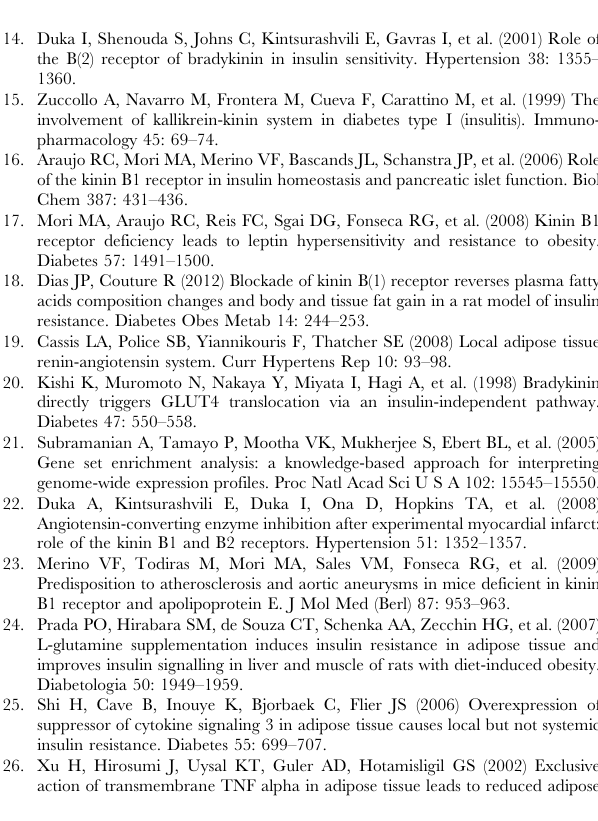
Figure S4 Lipid and glucose metabolism genes are not rescued by expression of kinin B 1 receptor in fat. Expression of GLUT1, fatty acid synthase (FAS), acetyl-CoA carboxylase (ACC) and glycerol-3-phosphate acyltransferase-like (GPAT) mRNA in epididymal fat of random fed mice measured by realtime PCR. Data represent mean 6 SEM of six animals per group. *, P , 0.05; **, P , 0.001. (TIF) Figure S5 aP2-B1/B1 2 / 2 mice have smaller adipo- cytes. Animals were submitted to HFD and adipocyte size was estimated in histological sections of the epididymal fat pad. Values are means 6 SEM of six animals. Table S1 Gene Set Enrichment Analysis. Gene sets downreg- ulated in B1 2 / 2 mice adipose tissue versus WT and aP2B1- B1 2 / 2 adipose tissue. Table S2 Energy parameters. Table S3 Lipid parameters in the